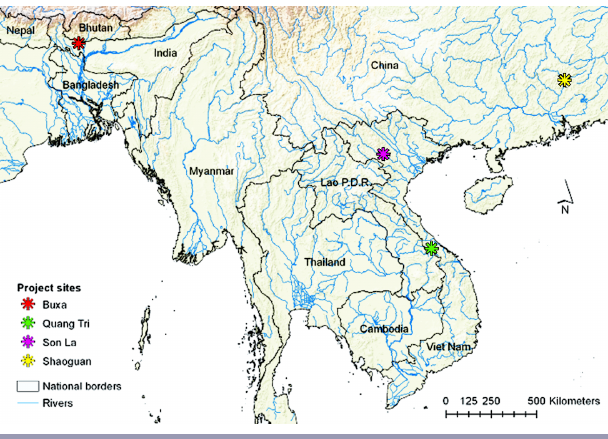
Fig. 1 . Map of HighARCS project